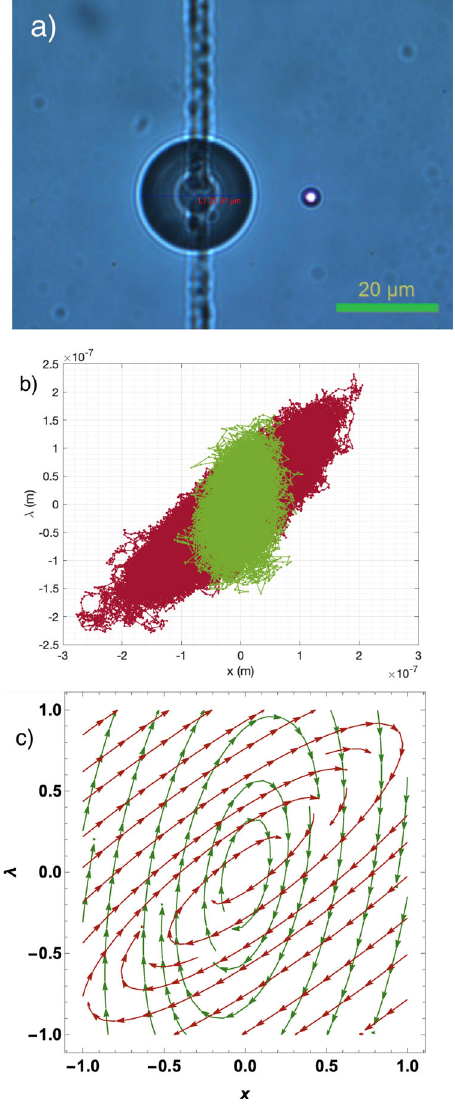
Fig. 5 The colloidal system in the presence of the bubble. a The microbubble – colloidal particle system. b System trajectories without (red) and with (green) the bubble in the neighborhood of the colloidal particle.